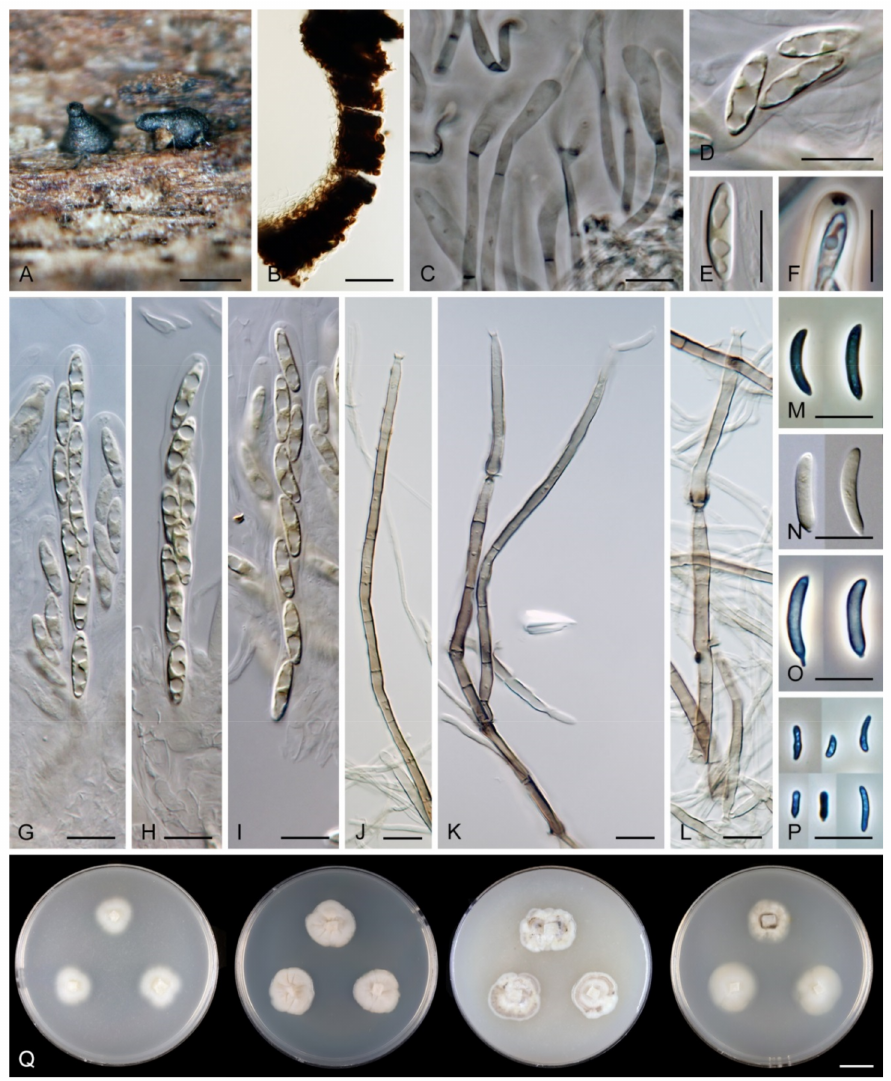
Figure 12. Phialoturbella calva . (ICMP 23826 ex-type) ( A ) ascomata ( B ) vertical section of the ascomal wall ( C ) paraphyses ( D , E ) ascospores ( F ) ascal apex with apical annulus ( G – I ) asci ( J – L ) conidiophores ( M – O ) macroconidia ( P ) microconidia ( Q ) colonies on CMD, MLA, OA and PCA after 4 weeks (from left to right). Images: ( A – I ) from nature; ( J – P ) on PCA after 6 weeks. Scale bars: ( A ) 250 µ m; ( B ) 20 µ m; ( C – P ) 10 µ m; ( Q ) 1